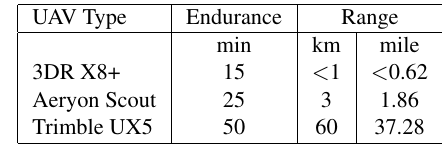
Table 1: Target UAV characteristics